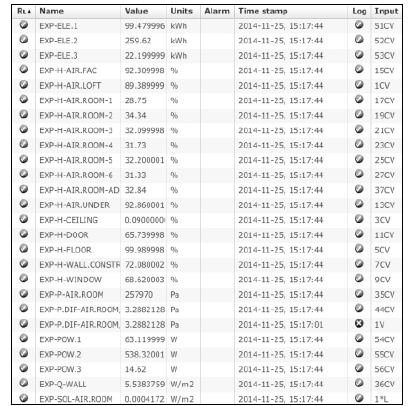
Fig. 10. Real time data screenshot of data logger web